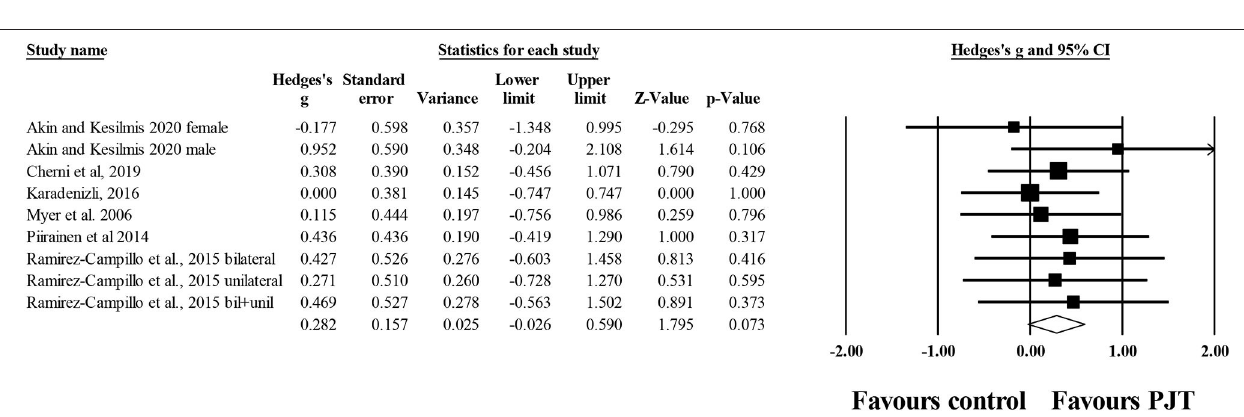
FIGURE 5 | Forest plot of changes in dynamic balance, measured through laboratory-based equipment, in participants that completed a plyometric jump training (PJT) program compared to participants allocated as controls. Values shown are effect sizes (Hedges’s g) with 95% confidence intervals (CI). The size of the plotted squares reflects the statistical weight of each study. The diamond reflects the overall